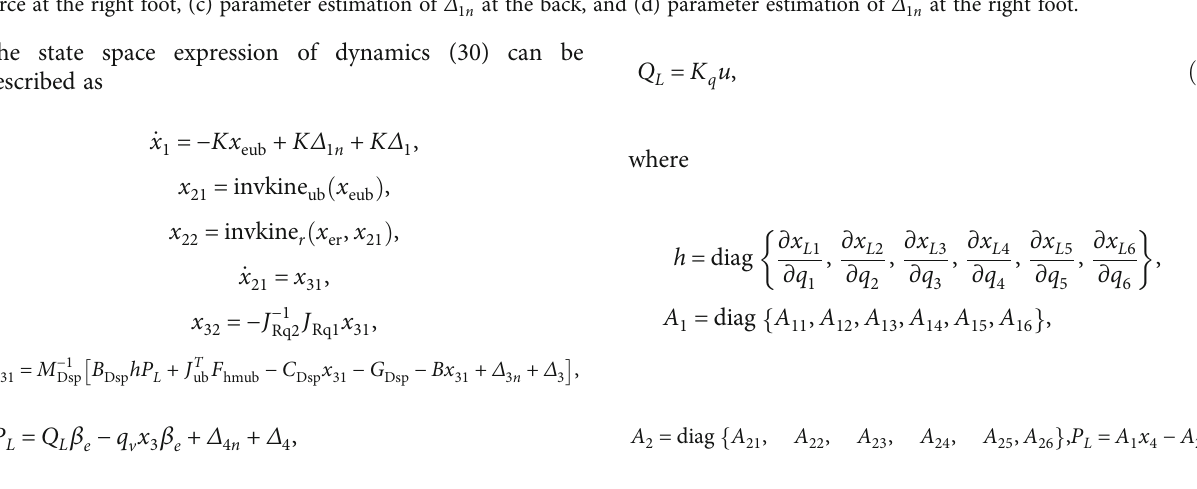
at the right 1 n